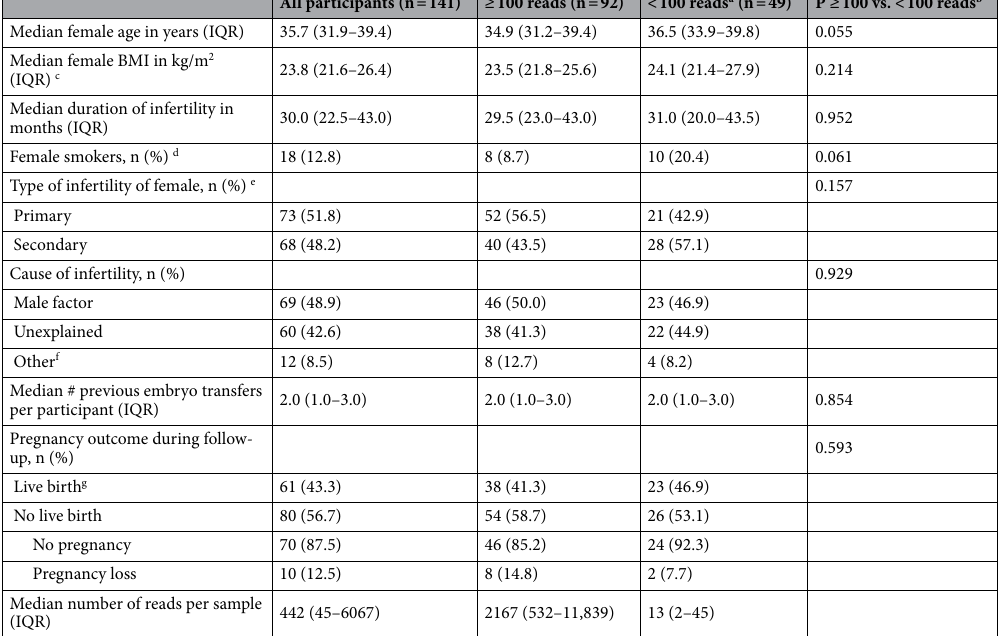
Table 1. Characteristics of all participants and by number of bacterial reads (≥ 100 and < 100). BMI body mass index, IQR interquartile range. a Seven samples had 0 reads. The clinical characteristics of this group did not differ from the other 42 women who had between 1 and 99 reads, with the exception of smoking. b All continuous variables were compared using the Wilcoxon rank sum test, whereas all categorical variables were compared using the Fisher’s exact test. c Data was missing for one participant in the ≥ 100 reads group. d Data was missing for one participant in the < 100 reads group. e Primary: female has never conceived before. Secondary: female has conceived before. f Other causes of infertility are tubal factor (≥ 100 reads: n = 1, < 100 reads: n = 4), ovulatory disorder (≥ 100 reads: n = 3), endometriosis (≥ 100 reads: n = 1) and mixed causes (≥ 100 reads: n = 3). g One woman conceived spontaneously, and all other women conceived via IVF/ICSI. The sample of the woman who conceived spontaneously had < 100 bacterial reads and was therefore not included in the